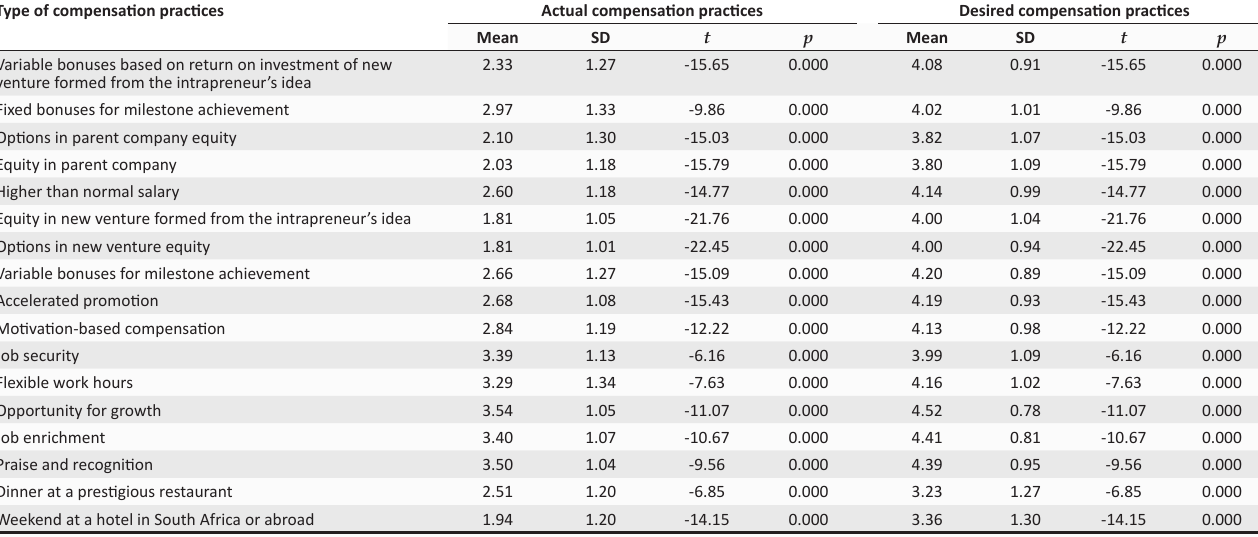
TABLE 1: Mean score differences between actual versus desired compensation